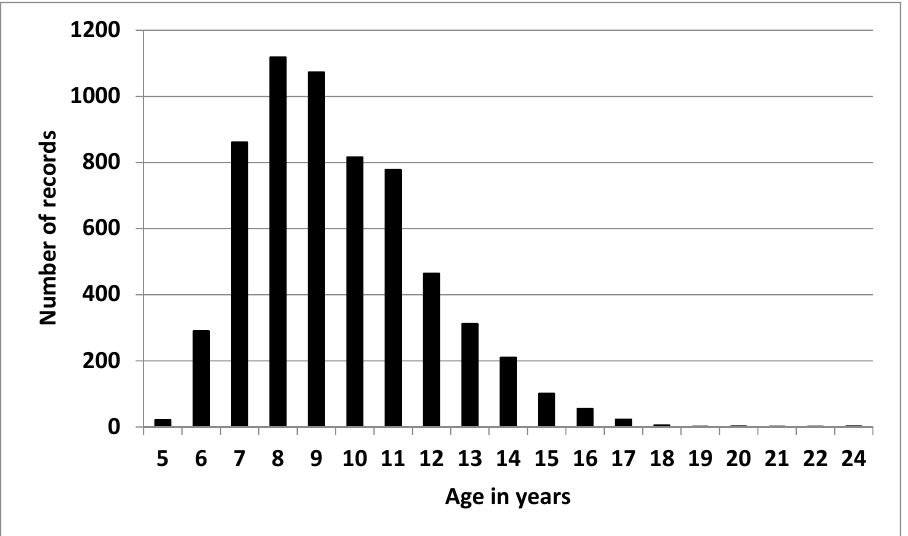
Figure 1. Distribution of records regarding age in years.